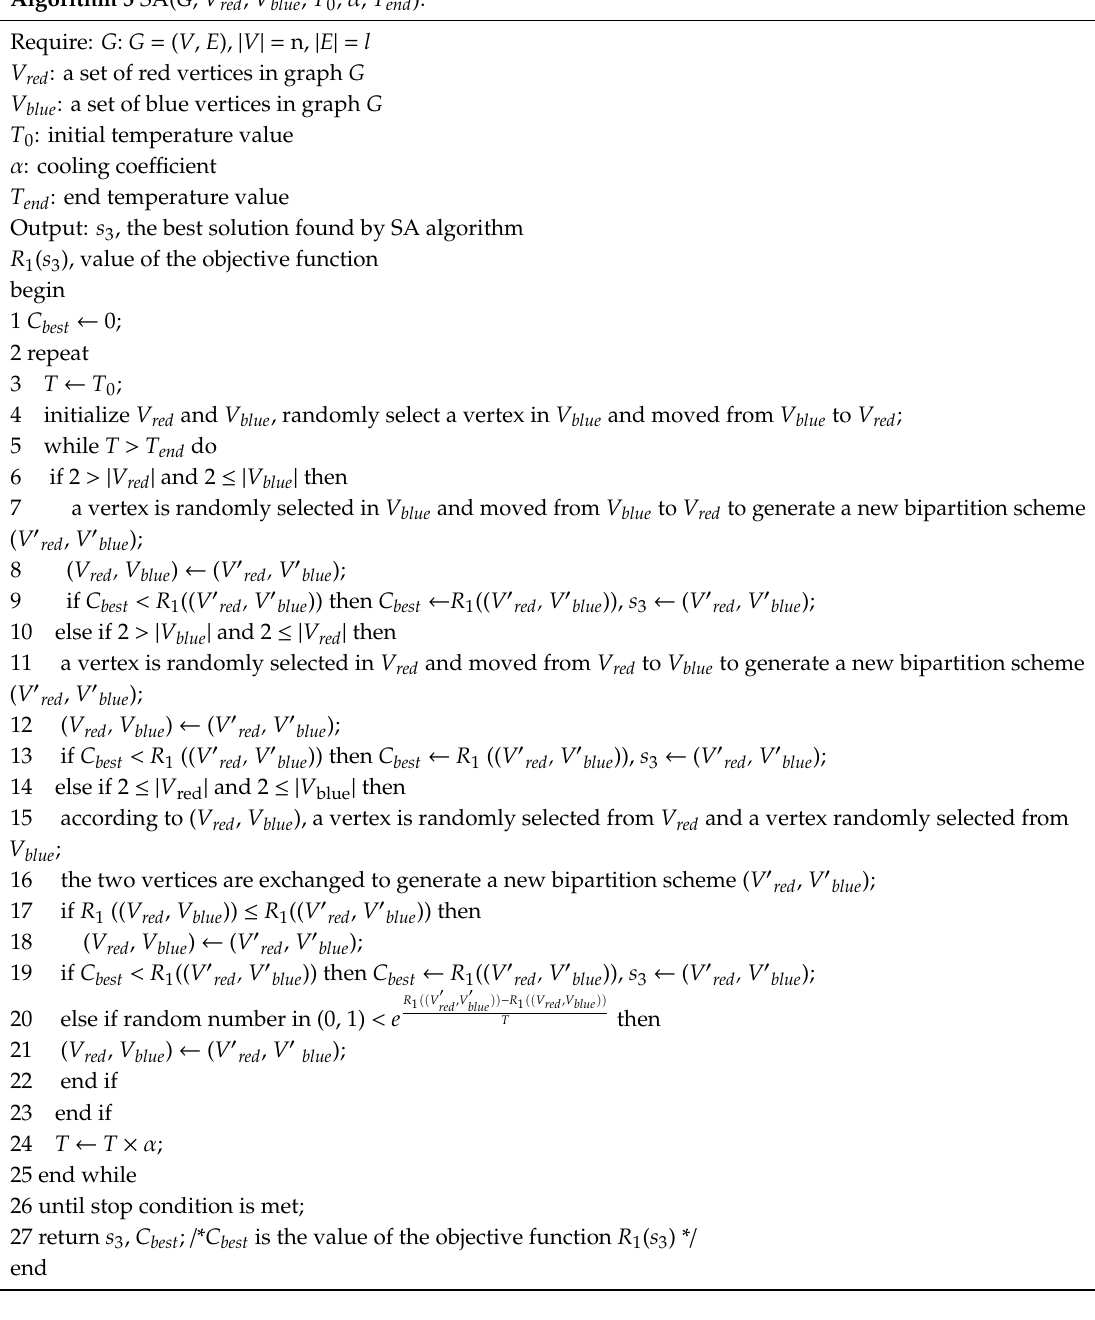
Algorithm 5 SA( G , V red , V blue , T 0 , α , T end